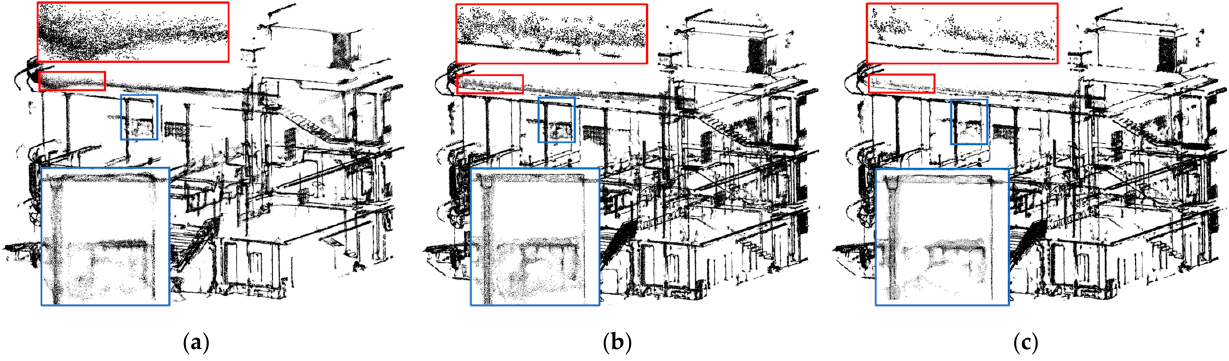
Figure 14. Results of the upsampling when using ( a ) PU-NET, ( b ) PU-GAN, and ( c ) our proposed deep learning network. Each large rectangle shows the enlarged image of the area indicated by the small rectangle with the same shape, corre- sponding to Figure 13.